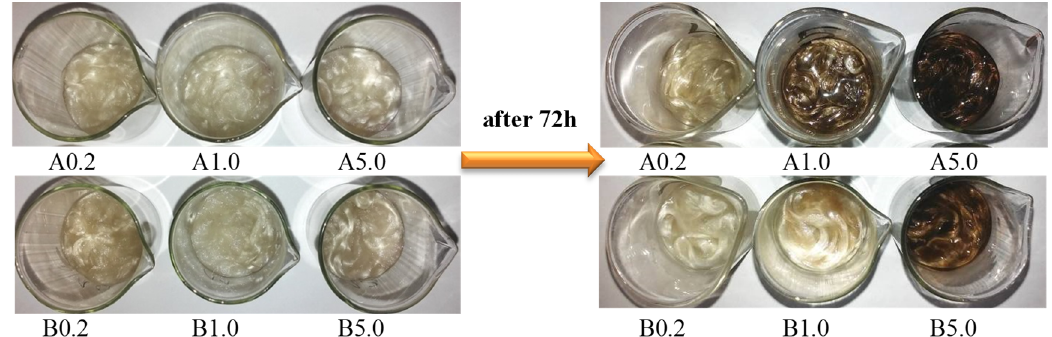
Figure 2. The samples before and after 72h to application of theAgNO 3 .